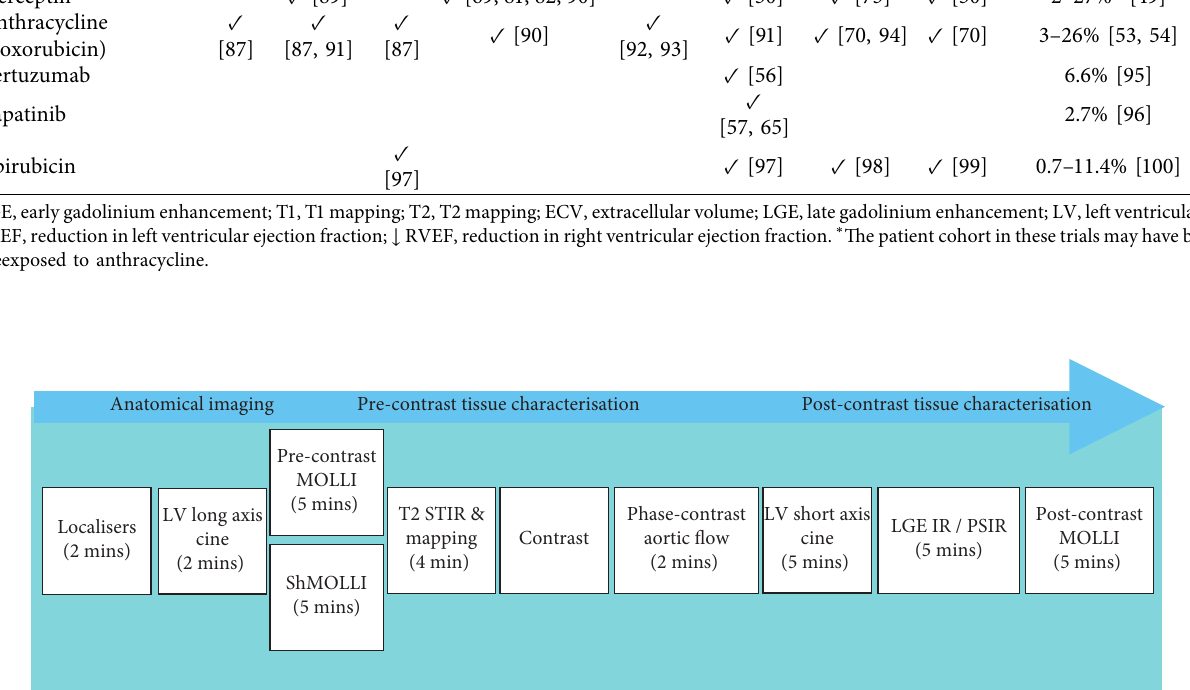
Figure 4: Proposed 30-minute cardiac magnetic resonance imaging protocol for the assessment of trastuzumab cardiotoxicity. LV, left ventricle; MOLLI, modified look-locker inversion recovery; ShMOLLI, shortened modified look-locker inversion recovery; STIR, short tau inversion recovery; IR, inversion recovery; PSIR, phase-sensitive inversion